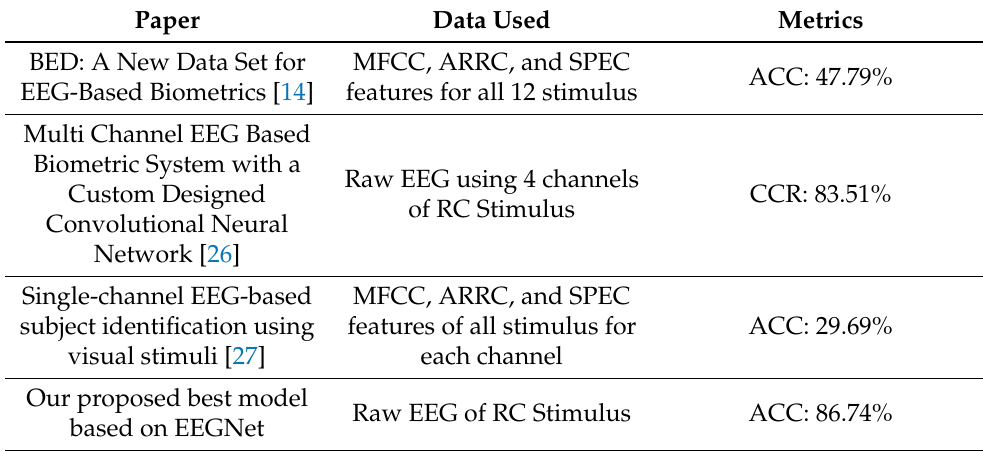
Table 2. Comparison with existing